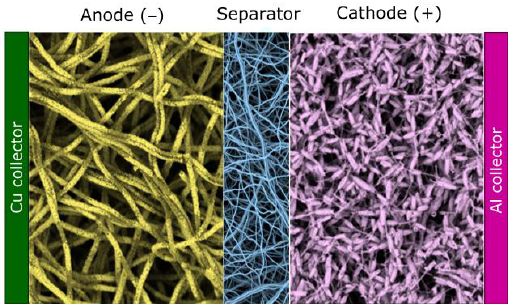
Figure 5. Sketch of LIB consisting exclusively of electrospun components, inspired to those proposed in [93].